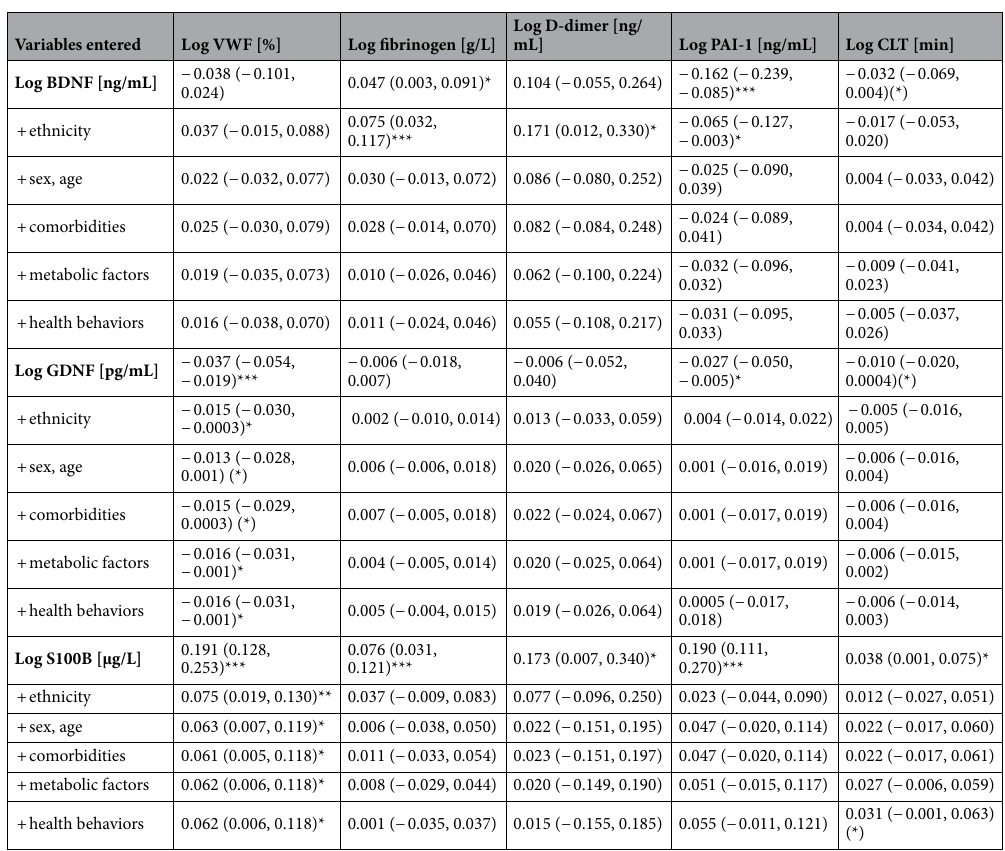
Table 2. Regression models for the associations between neurotrophins and hemostatic factors at baseline. BDNF, brain-derived neurotrophic factor; CLT, clot lysis time; GDNF, glia cell-line derived neurotrophic factor; PAI, plasminogen activator inhibitor; S100B, S100 calcium-binding protein B; VWF, von Willebrand factor. Unstandardized coefficients B (95% confidence interval) indicate associations between (log) neurotrophic and hemostatic factors with subsequent adjustment for blocks of covariates. Significance level: (*) p < 0.10, * p < 0.05, ** p < 0.01, *** p < 0.001. Comorbidities: Human immunodeficiency virus positive status, history of atherothrombotic disease. Metabolic factors: Body mass index, hemoglobin A1c, total cholesterol to high-density lipoprotein cholesterol ratio; mean 24-h arterial pressure, estimated glomerular filtration rate, high-sensitivity C-reactive protein. Health behaviors: Current smoking, physical activity, excessive alcohol